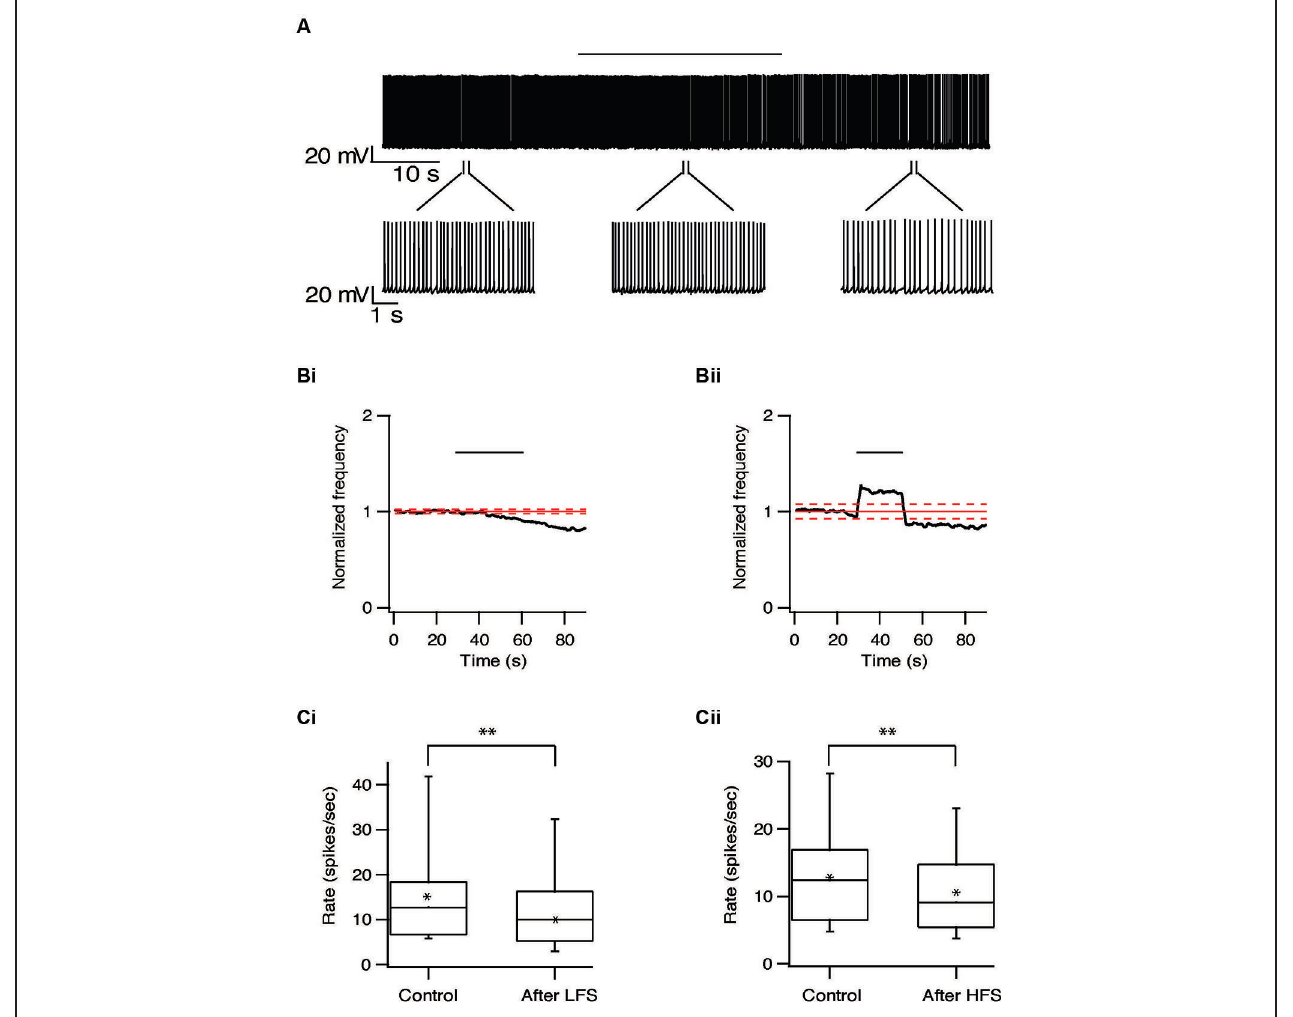
FIGURE 7 | Long-term depression in the GP induced by repetitive stimulation. (A) Representative recording from a pallidal neuron during 10 Hz stimulation of the STN. Stimulation artifact was removed to improve visualization of the neuronal activity. Horizontal line above indicates period of stimulation. (B) Changes in normalized population firing rate of pallidal